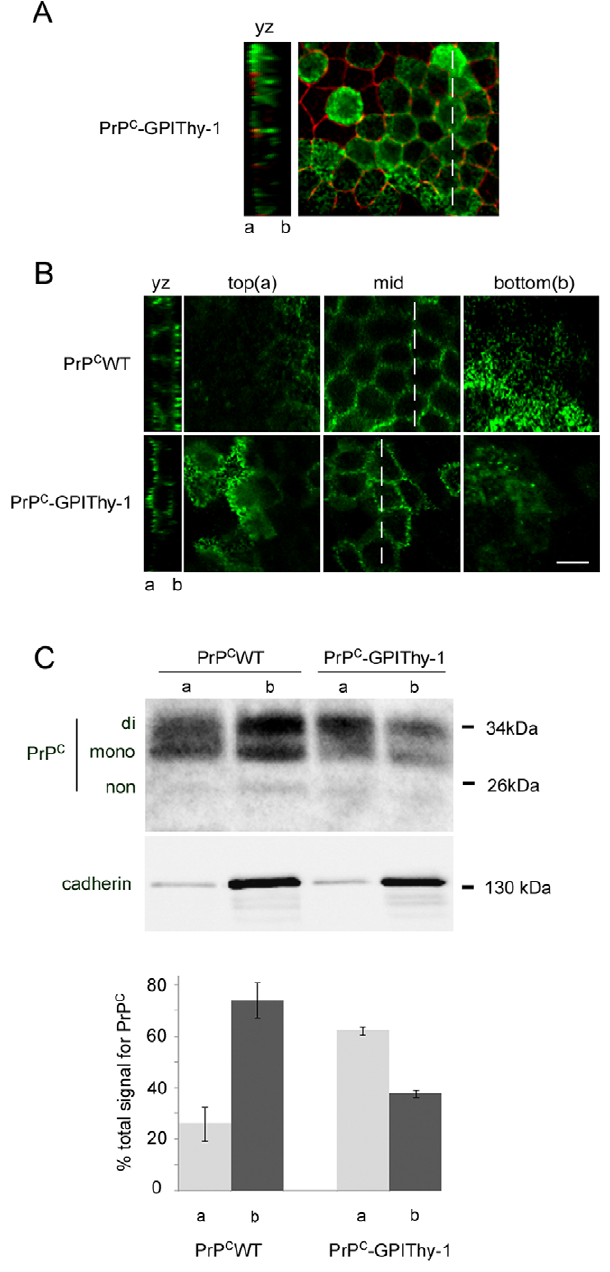
Figure 6. Thy-1-GPI anchor redirects PrP C to the apical site. (A) Cells stablyexpressing PrP C WTand PrP C -GPIThy-1were growninTranswells for 4 to 5 days, processed for immunocytochemistry, and analyzed with confocal microscopy. YZ sections (left) and view on the membrane (right) at the level of tight junctions stained for ZO-1 (red) confirm both polarization and confluency of cells and show increased apical signal for PrP C -GPIThy-1 (green). (B) After staining with PrP 3F4 antibody under non-permeabilizing conditions, serial Z-stacks from the bottom to the top were taken. YZ sections show transversal cut through cells at the level of the dashed line in mid. PrP C -GPIThy-1 was found at the apical membrane when compared to PrP C WT. Scale bars are 10 m m. (C) Cells grown inTranswells labeled with EZ- Link Sulfo-NHS-SS-Biotin either apically (a) or basolaterally (b) were processed for Western blotting for PrP C and E-Cadherin (as control of cell polarization) in parallel. The graph (three independent experiments) shows mean percentages 6 SEM of apical (a) or basolateral (b) amount of protein when compared to the total amount which is set at 100%.